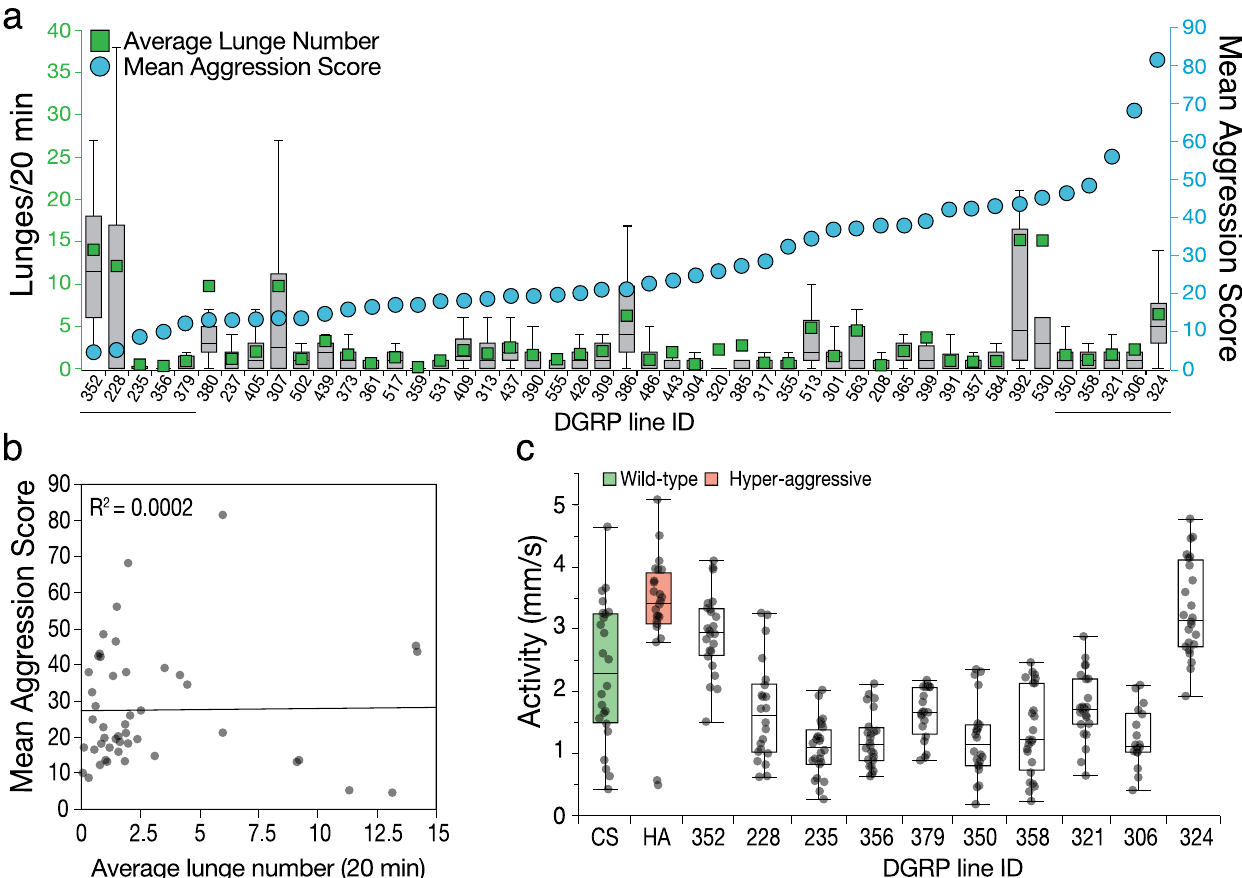
Fig. 5 Mean Aggression Score (MAS) does not measure aggression. a Median (line in the box) and average lunge (green square) numbers of 47 DGRP strains that were previously analyzed for MAS (blue circles). None of the strains have lunge numbers above 15 in 20 min interval (very low or no aggression in the range of CS). MAS varies 20-fold from ~4 in the lowest strain to ~80 in the highest strain. b Regression analysis shows that both parameters — lunge number and MAS — are not correlated ( R 2 = 0.0002, n = 12 – 24). c Average locomotion data over 20 min of the fi ve DGRP strains with lowest MAS and fi ve DGRP strains with the highest MAS compared to the low (green horizontal bar) aggression and hyper-aggressive (red horizontal bar) strains. Most of the DGRP strains have signi fi cantly lower locomotor activity than CS (nonparametric Steel method with CS as the control, 352, p = 0.35; 228, p = 0.33; 235, p = 0.0007; 356, p = 0.0054; 379, p = 0.30; 350, p = 0.0077; 358, p = 0.027; 321, p = 0.42; 306, p = 0.018; 324, p = 0.044; Aggr, p = 0.02). Boxplots show the median, fi rst and third quartiles as boxes, with whiskers representing the 5 and 95%